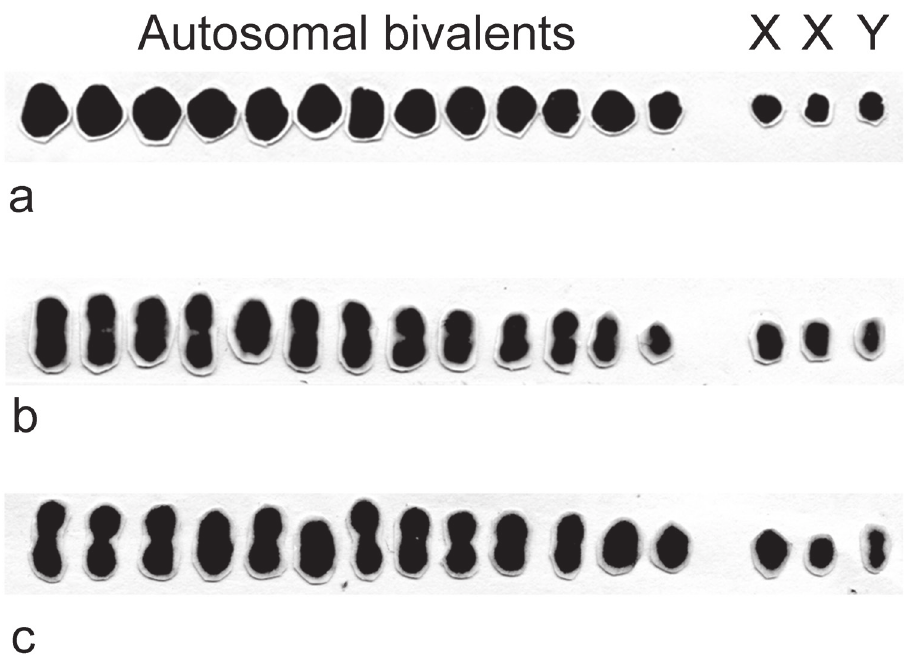
Figure 1. Male meiotic karyotypes of B. dentatum ( a ), B. elongatum ( b ) and B. gestroi ( c ), 2n = 13II + X X Y, stained with 2% iron-propionic 1 2